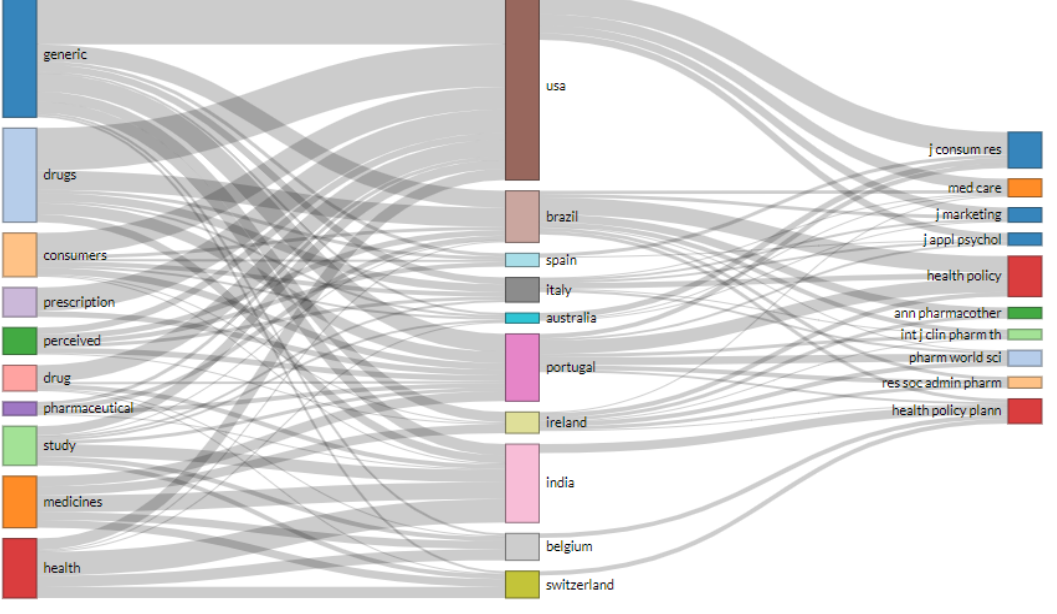
Figure 5. Three-field plots.